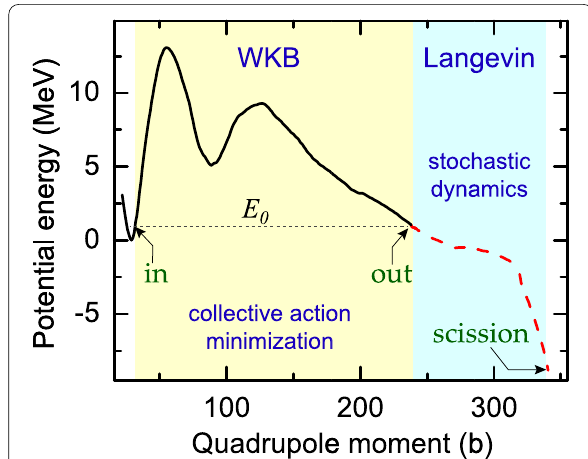
Fig. 8 Potential energy of 240 Pu calculated along the most probable fission path. In the classically forbidden region (marked WKB; between the inner turning point “in” and outer turning point “out”), the collective action is minimized to determine the half-life. In between the outer turning point and scission, the evolution of the system can be described by stochastic Langevin dynamics. E 0 is the quantum zero-point energy at the ground state configuration. The x -axis gives the quadrupole moment of the fissioning nucleus and it is equivalent to the elongation coordinate used in mac-mic models. The figure is adapted from